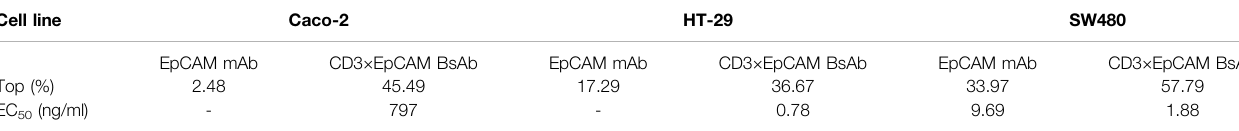
TABLE 2 | Cytotoxicity analysis of CD3×EpCAM BsAb and EpCAM mAb.